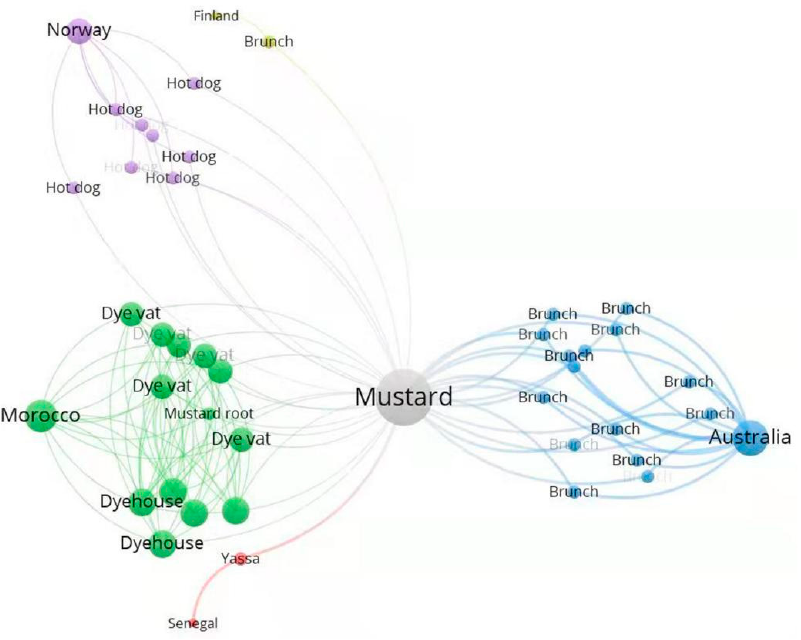
Figure 2. Knowledge graph of nodes connected to mustard. The graph was made by VOSviewer [25,26]. Circle size reflects the number of links. Nodes from the same country are clustered with the same color.